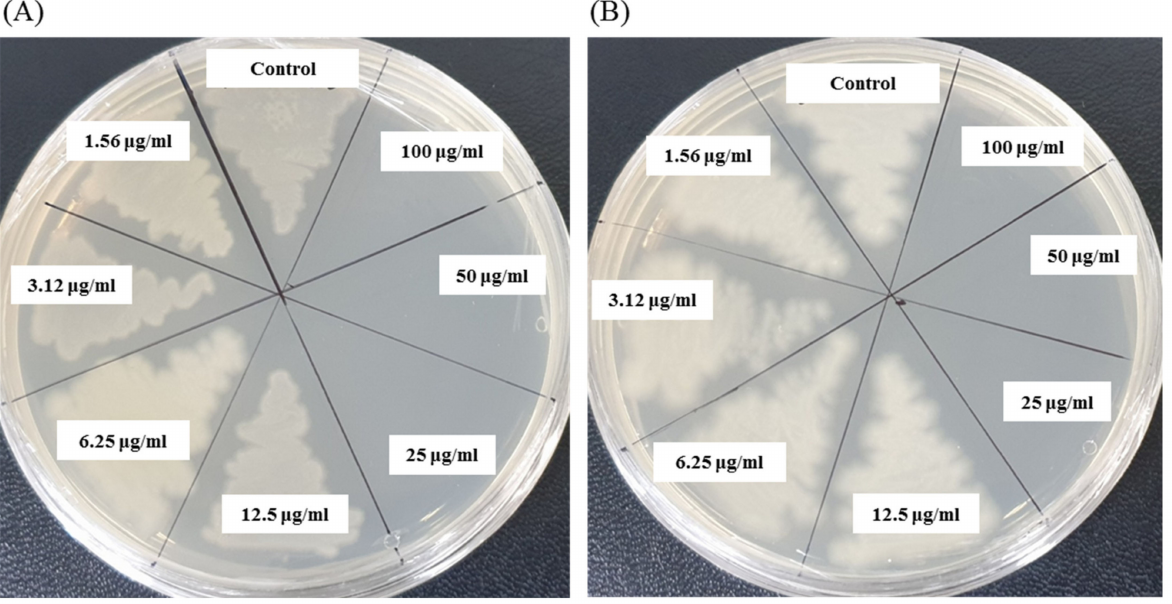
Figure 9. MBC of P. nicotinovorans MAHUQ-43-mediated synthesized AgNPs against P. aeruginosa ( A ) and B. cereus ( B